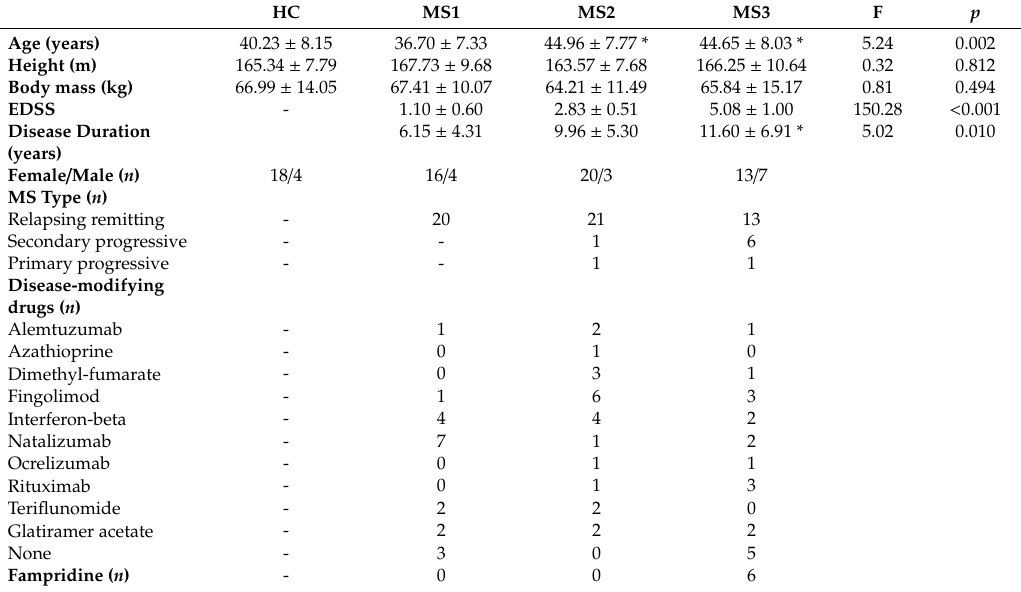
Table 1. Demographic, clinical characteristics and medications of the healthy controls and multiple sclerosis individuals stratified according to their Expanded Disability Status Scale (EDSS). HC